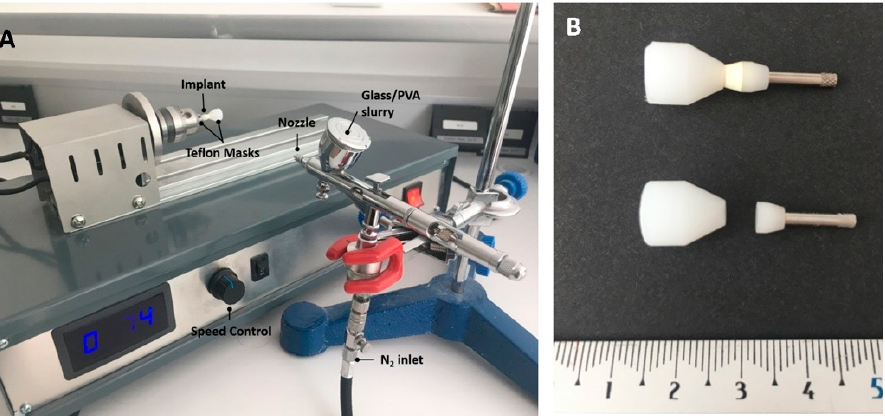
Figure 2. ( A ) Image of the device used for the coatings. ( B ) Photograph of the masks, with (above) and without (below) the abutment.